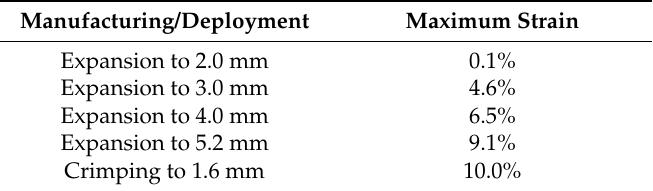
Table 2. Maximum strains encountered during manufacturing and deployment procedures.